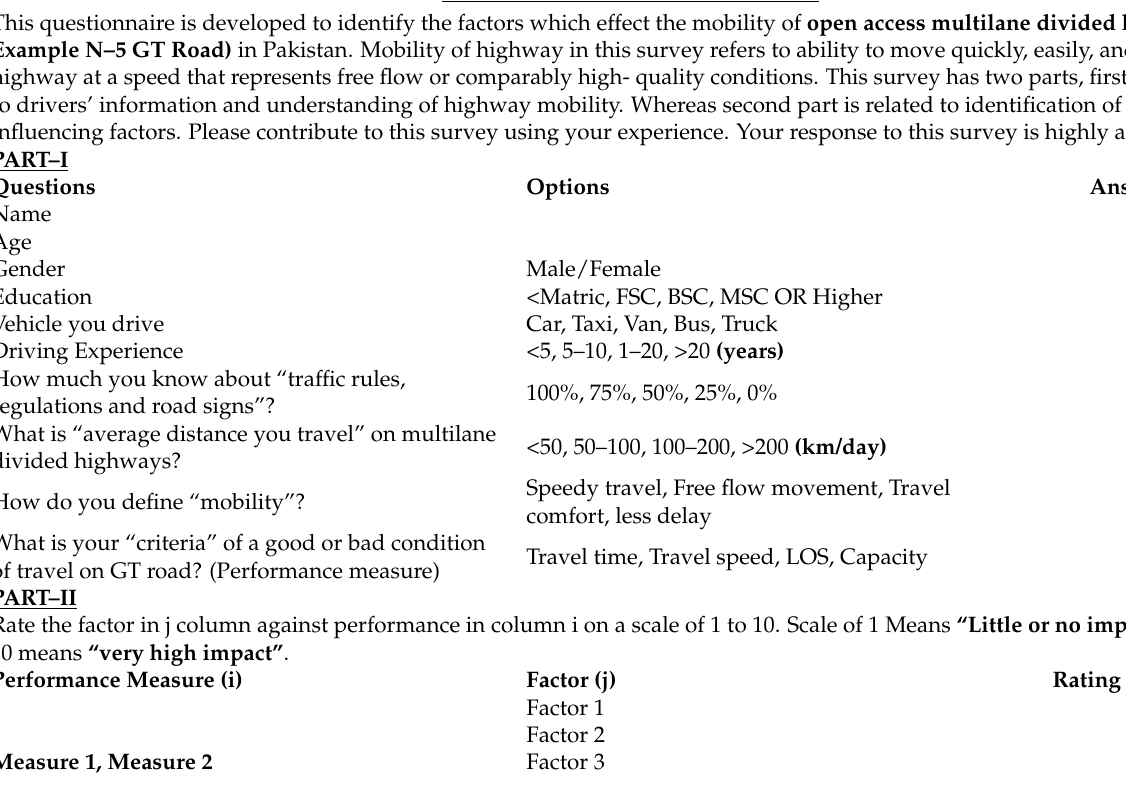
Table 3. Overview of User